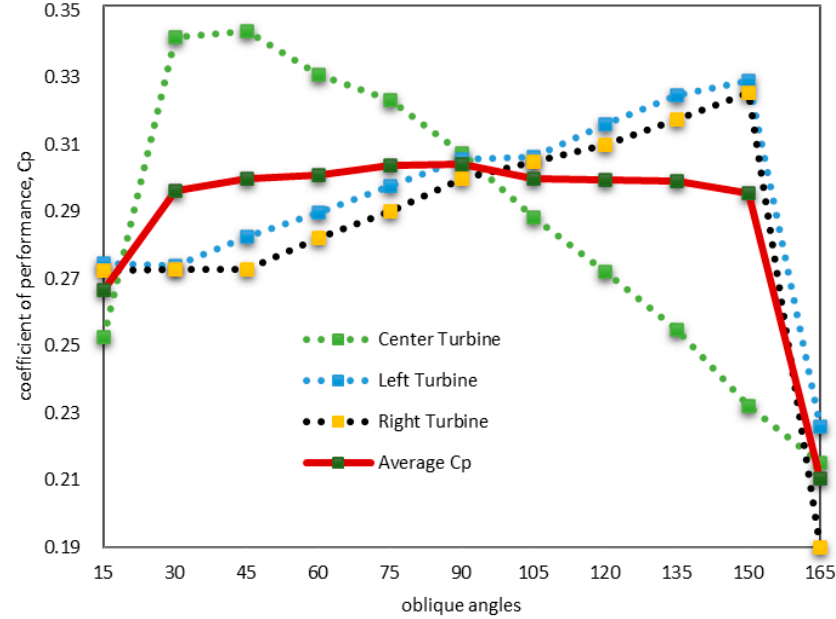
Figure 19. Trends in the power coefficient at different oblique angles.